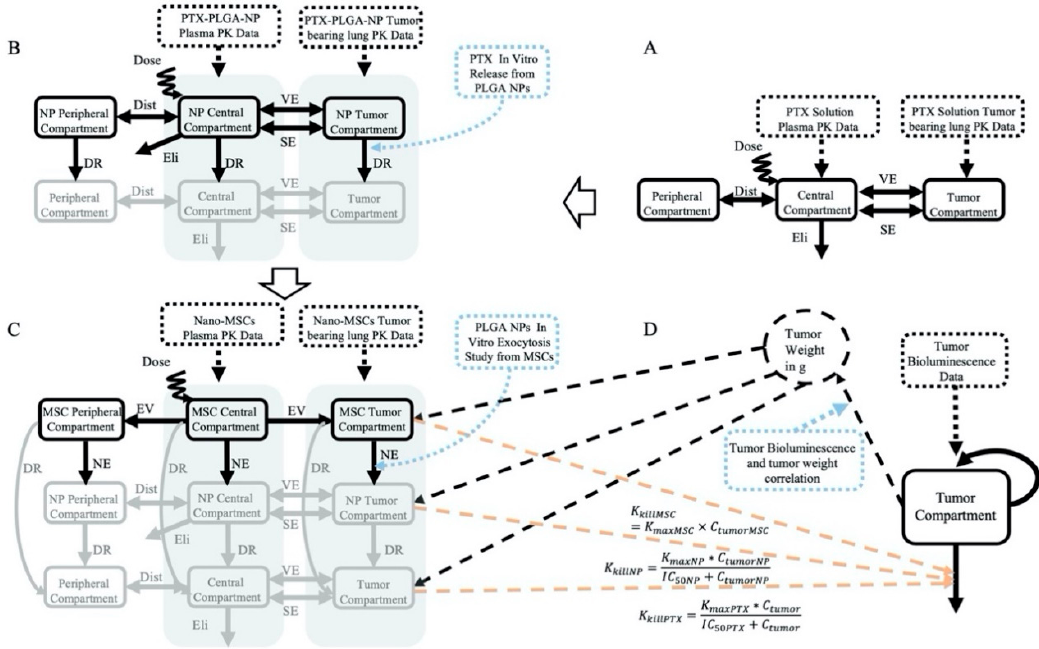
Figure 2. The structures of the PK models for the PTX solution ( A ), PTX-PLGA NPs ( B ), nano-MSCs ( C ) and structure of PK–PD model ( D ). The solid rectangles and solid arrows represent model compartments and inter-compartmental mass transfer, respectively. The black dotted rectangles represent the data used for each model fitting. The gray shaded areas represent the summation of compartmental concentrations. The black dotted arrows indicate the associations between model compartments and data. The blue dotted rectangles and blue dotted arrows represent the parameters derived from in vitro/in vivo studies. The dashed lines represent connections between PK and PD models without mass transfer. Specifically, the connections between the PK model derived drug concentrations and the tumor killing processes are shown in red color. Notes: Eli: elimination; Dist: distribution; VE: vascular exchange; SE: surface exchange; DR: drug release; NE: NP exocytosis; EV: extravasation.